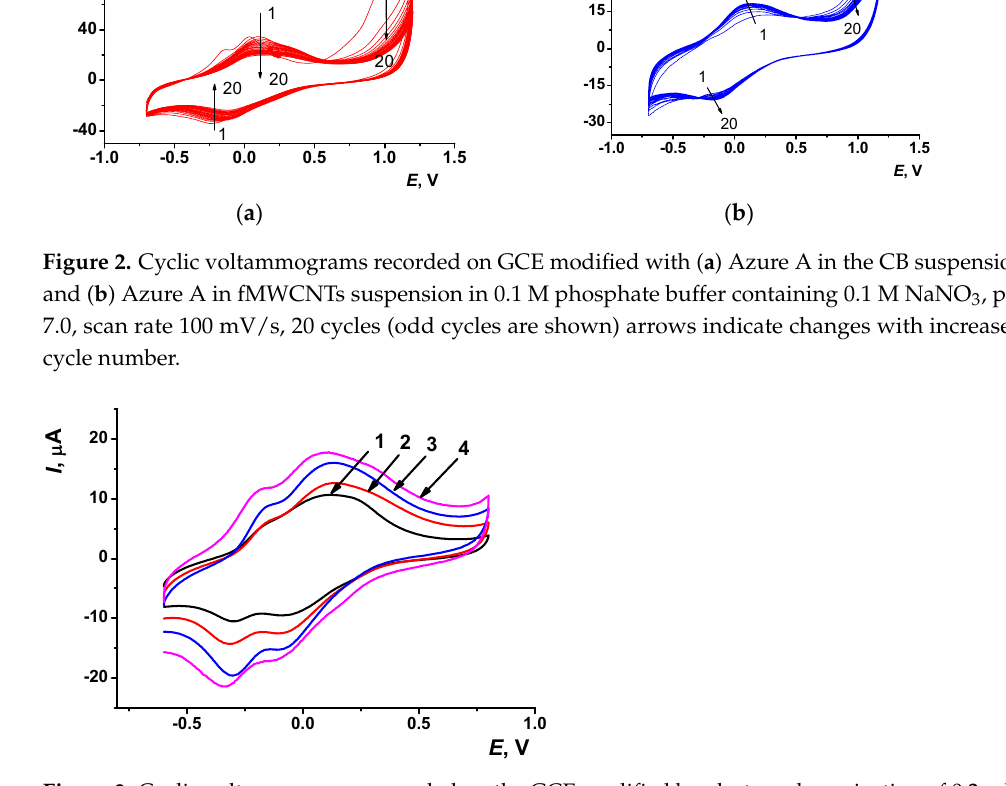
Figure 3. Cyclic voltammograms recorded on the GCE modified by electropolymerization of 0.2 mM Azure A solution (1), Azure A placed on the GCE in suspension with chitosan (2), in suspension with chitosan and CB (3), in suspension with fMWCNTs and chitosan (4). Measurements in 0.1 M phosphate buffer containing 0.1 M NaNO 3 , pH 7.0, scan rate 100 mV/s. The stability of electrochemical response was tested for both coatings with six indi ‐ vidual electrodes. The polymer signal was found to be more stable against that of the monomeric dye. The reduction peak of the polymer did not depend on the number of measurements consecutively performed in the same buffer with intermediate stirring of the solution, while the oxidation counter peak was stabilized to the fifth measurement. Monomeric dye peak currents grew until the seventh measurement, probably due to in ‐ creased permeability of the layer.